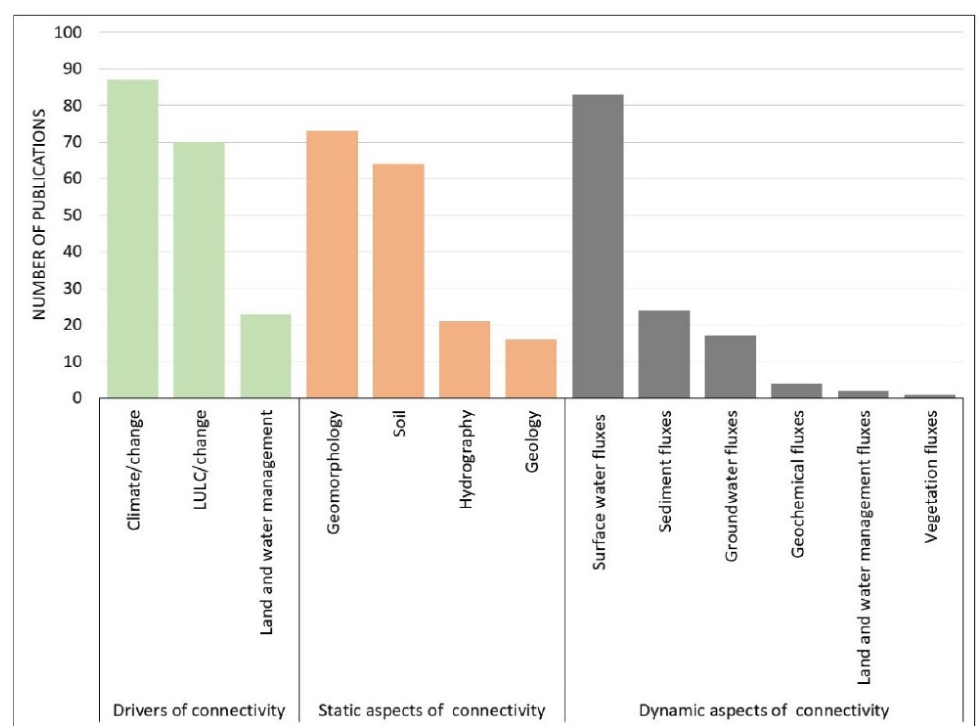
Figure 3. Number of publications addressing aspects of hydrologic connectivity, based on the concepts proposed by Keesstra, et al. [16].